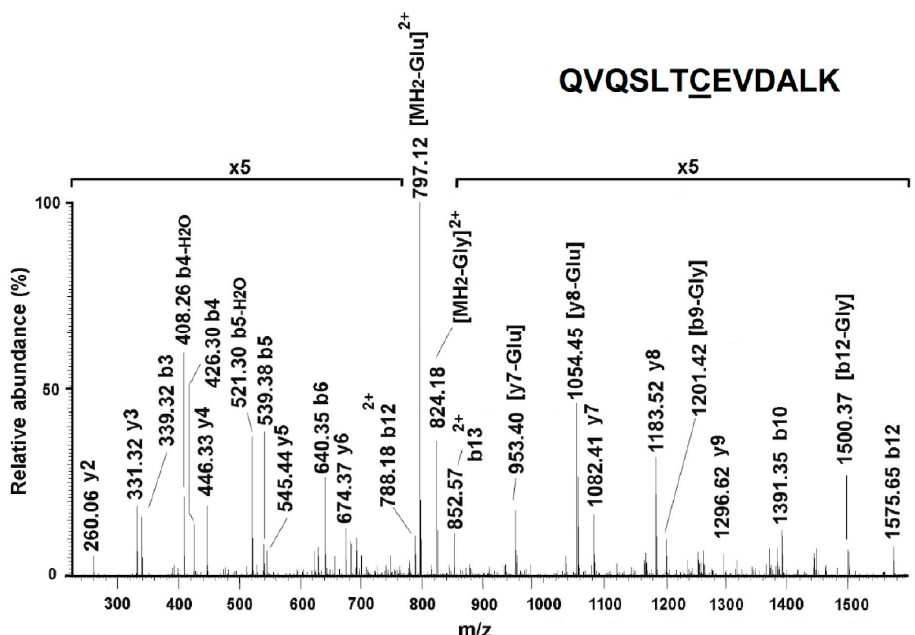
Figure 5. Identification of S -glutathionylated cysteine 328 in vimentin. Collision induced dissociation fragmentation spectrum of the doubly charged ( m / z 862.3) modified peptide (322–334) from vimentin-bearing S -glutathionylated Cys328. This peptide was isolated in spot 10 from K − / − cells (Figure 4B,E). Assigned fragments are reported in the spectrum, together with the peptide sequence where the modified residue is underlined. Glu, glutathione.